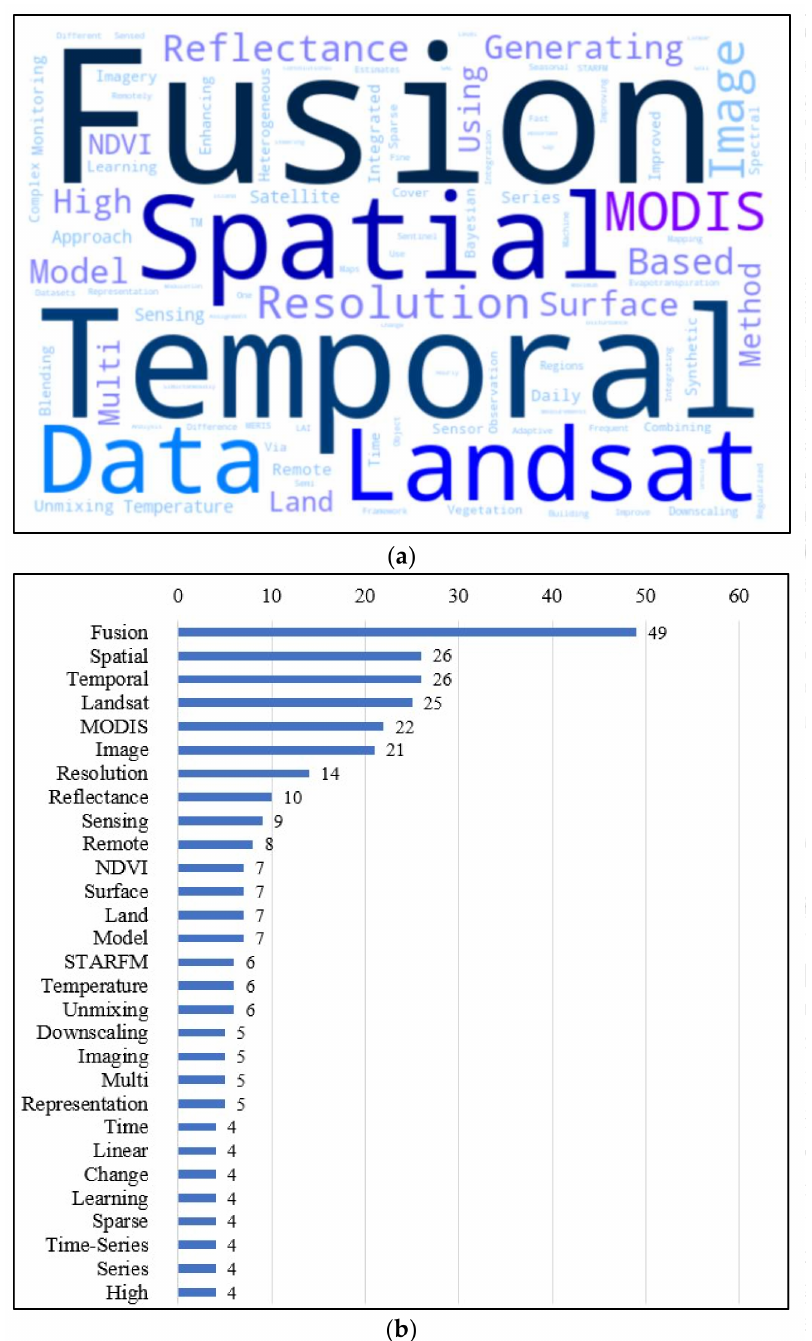
Figure 3. ( a ) A tag cloud of the literature titles of the 58 papers introducing new spatiotemporal fusion methods, where a larger font and darker color denote a higher frequency; and ( b ) count of keywords with frequency larger than